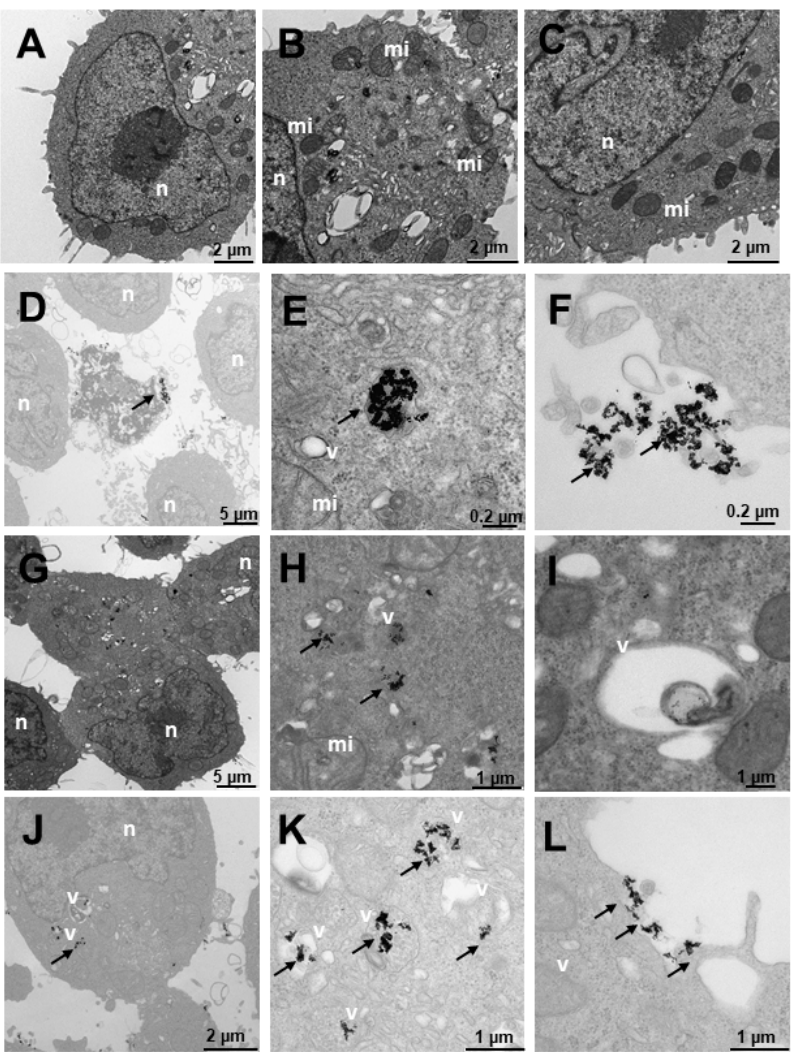
Figure 10. Transmission electron microscopy (TEM) photomicrographs of control cells without treatment ( A – C ), compared to Au@16-Ph-16 (N 3 ) ( D – F ), Au@16-Ph-16/DNA/Doxo (C 3 ) ( G – I ) and Au@16-Ph-16/DNA/Doxo + Au@16-Ph-16 (C 3 + N 3 ) ( J – L ) at 24 h, in LNCaP cells derived from tumorigenic prostate tumor cells from a hormone-sensitive prostate cancer model. The dense bod- ies indicated by an arrow are compatible with the gold core of the nanoparticles. Abbreviations: mi—mitochondria; n—nucleus and